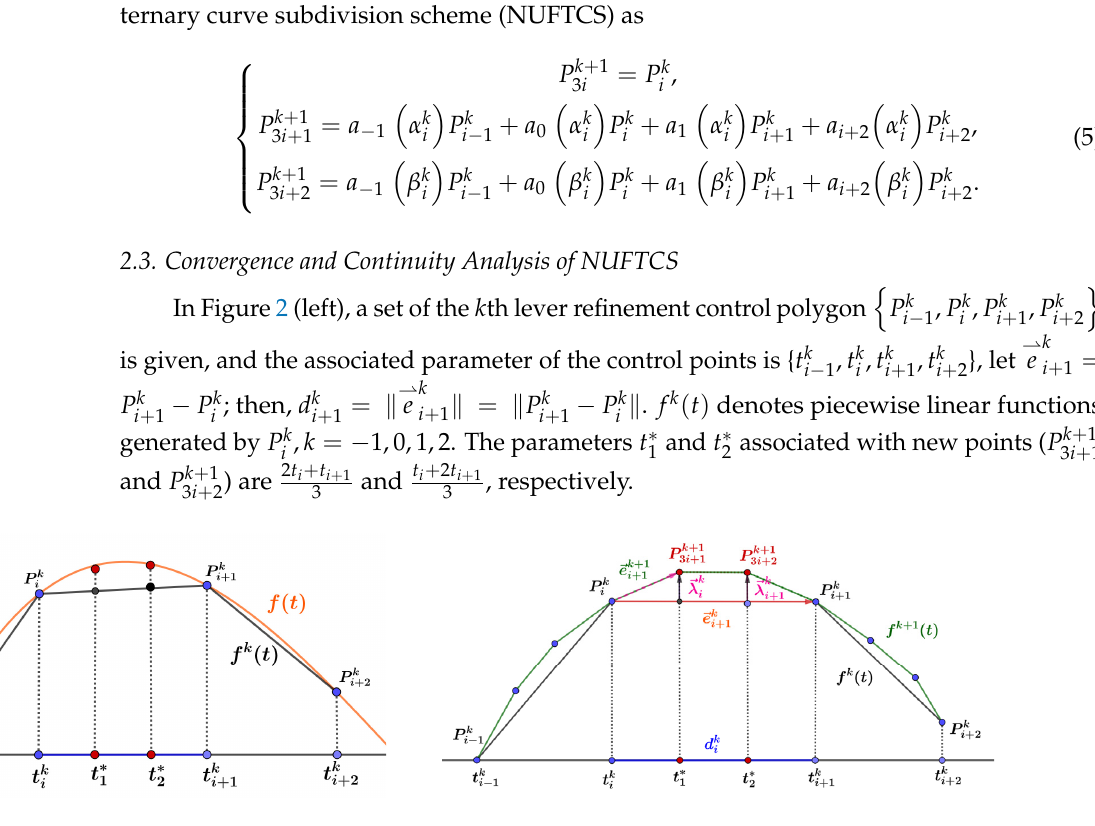
Figure 2. Left: the orange solid line ( 𝑓(𝑡) ) is a polynomial function through 𝑃 (cid:3036)(cid:2879)(cid:2869)(cid:3038) ,𝑃 (cid:3036)(cid:3038) ,𝑃 (cid:3036)(cid:2878)(cid:2869)(cid:3038) ,𝑃 (cid:3036)(cid:2878)(cid:2870)(cid:3038) , and the piecewise broken line ( 𝑓 (cid:3038) (𝑡) ) is a line through 𝑃 (cid:3036)(cid:2879)(cid:2869)(cid:3038) ,𝑃 (cid:3036)(cid:3038) ,𝑃 (cid:3036)(cid:2878)(cid:2869)(cid:3038) ,𝑃 (cid:3036)(cid:2878)(cid:2870)(cid:3038) . Right: insertion of the new points ( 𝑃 (cid:2871)(cid:3036)(cid:2878)(cid:2869)(cid:3038)(cid:2878)(cid:2869) and 𝑃 (cid:2871)(cid:3036)(cid:2878)(cid:2870)(cid:3038)(cid:2878)(cid:2869) ). Theorem 1 . The NUFTCS scheme is convergent.